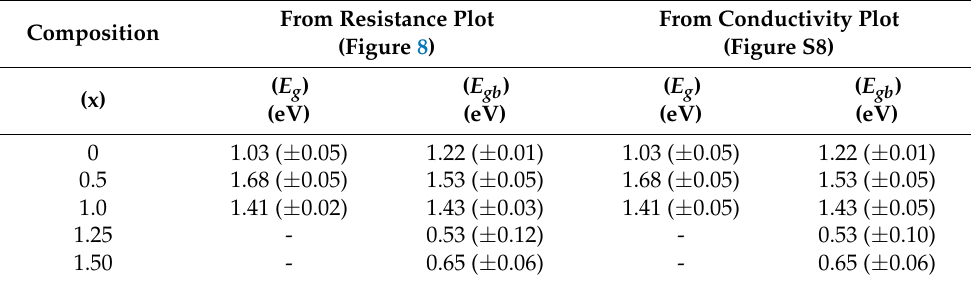
Table 3. Activation energies for the ionic process from both grain ( E g ) and grain boundary ( E gb ) for different compositions, as calculated from resistances and conductivity plots from the Arrhenius regime only. The error value is described in parenthesis. ‘-’ represents undetermined values. From Resistance Plot From Conductivity Plot Composition (Figure 8) (Figure